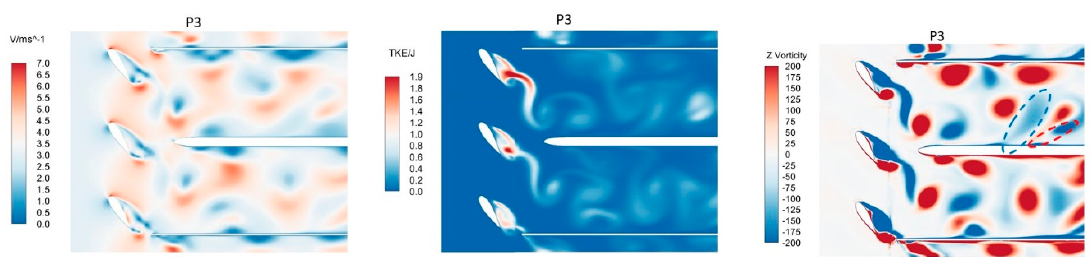
( a ) Contours at phase 1, left: velocity, middle: turbulence kinetic energy, right: z vorticity.